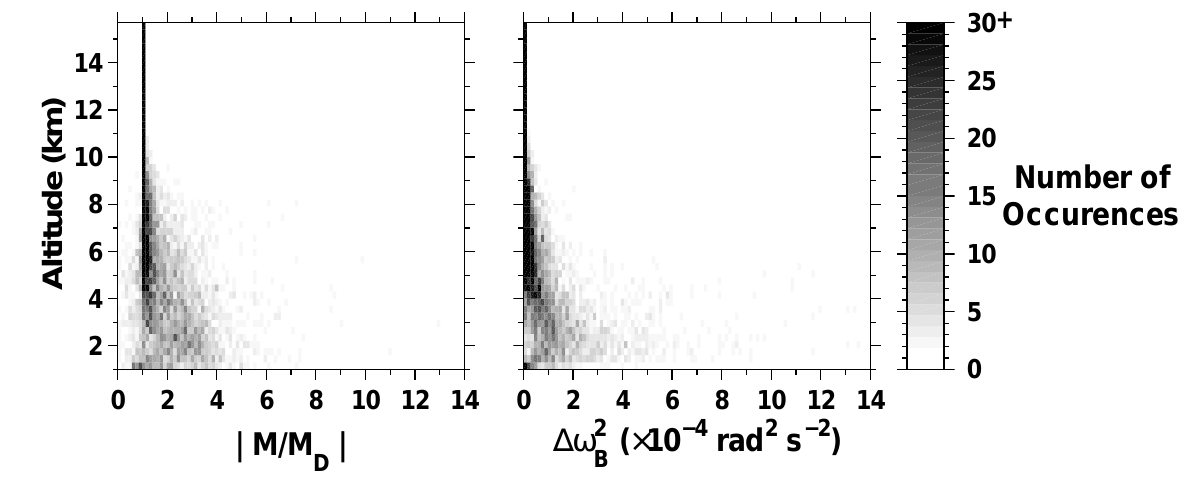
Fig. 4. Distributions of the | M/M D | values, by which radar-derived values of ω 2 the differences between the (non-humidity-corrected) radar-derived ω 2 functions of